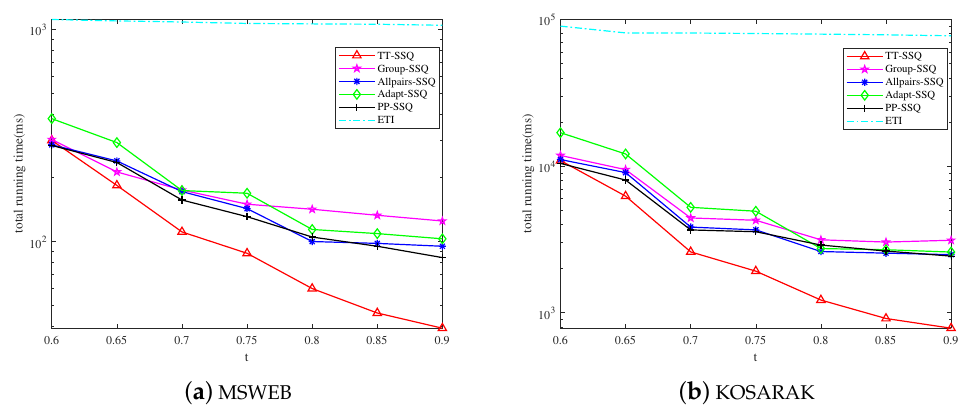
Figure 8. The comparisons among different